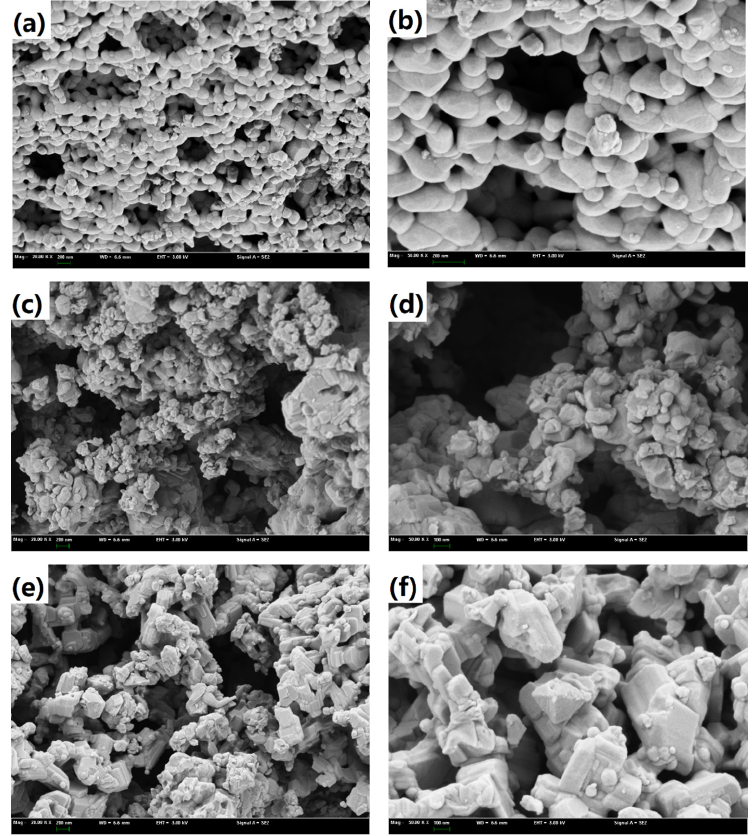
Figure 6. SEM images of oxygen carriers: ( a , b ) for LaFe; ( c , d ) for LaFe 1-x Ni x ; ( e , f ) for LaNi.